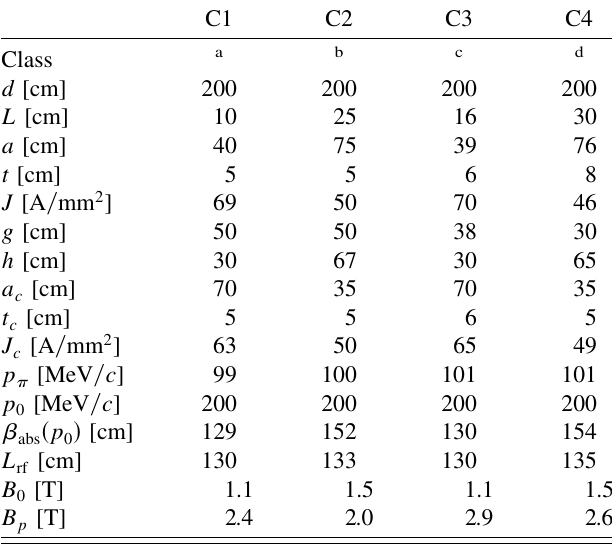
TABLE VI. Summary of the three-cell characteristic solutions for the first passband.